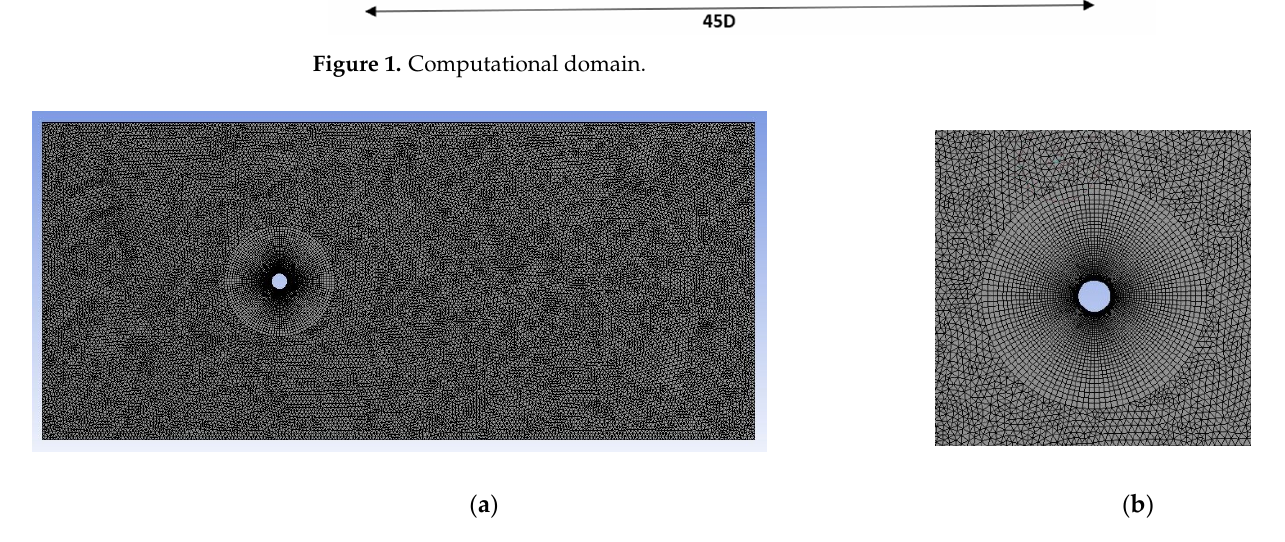
Figure 2. ( a ) Grid; ( b ) elements view (close-up).